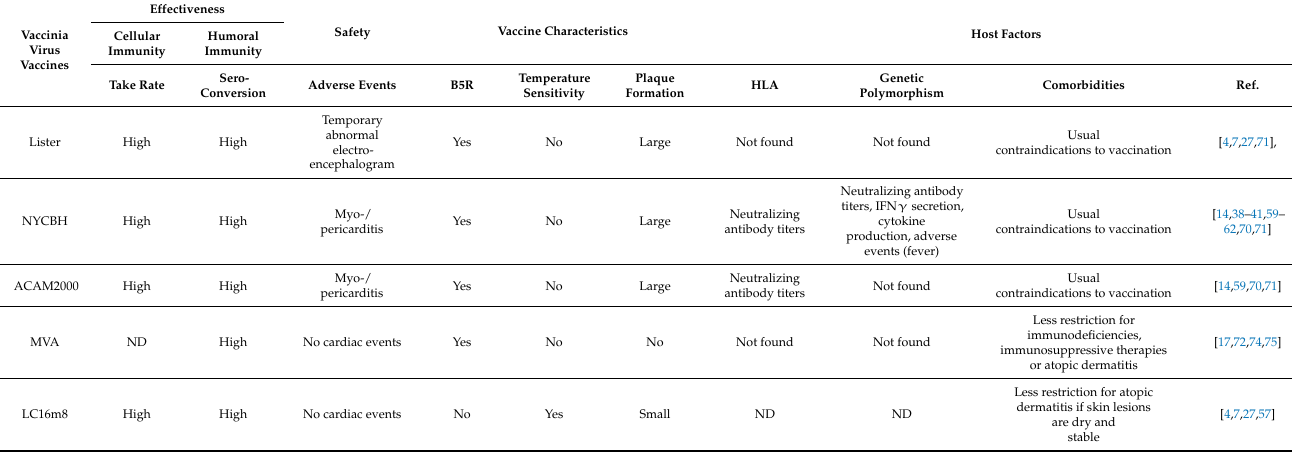
Table 2. Characteristics of VACV vaccines of the first, second, and third